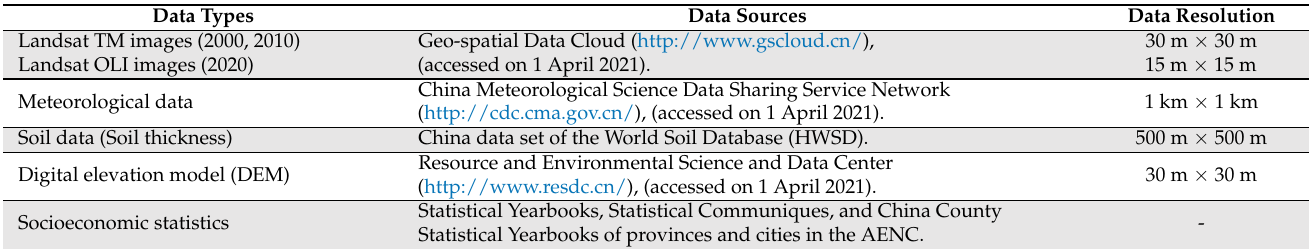
Table 1. Main data types and sources.